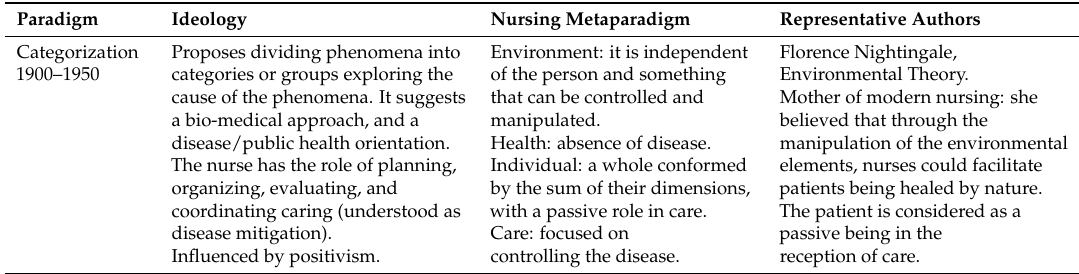
Table 1. Paradigms influencing nursing